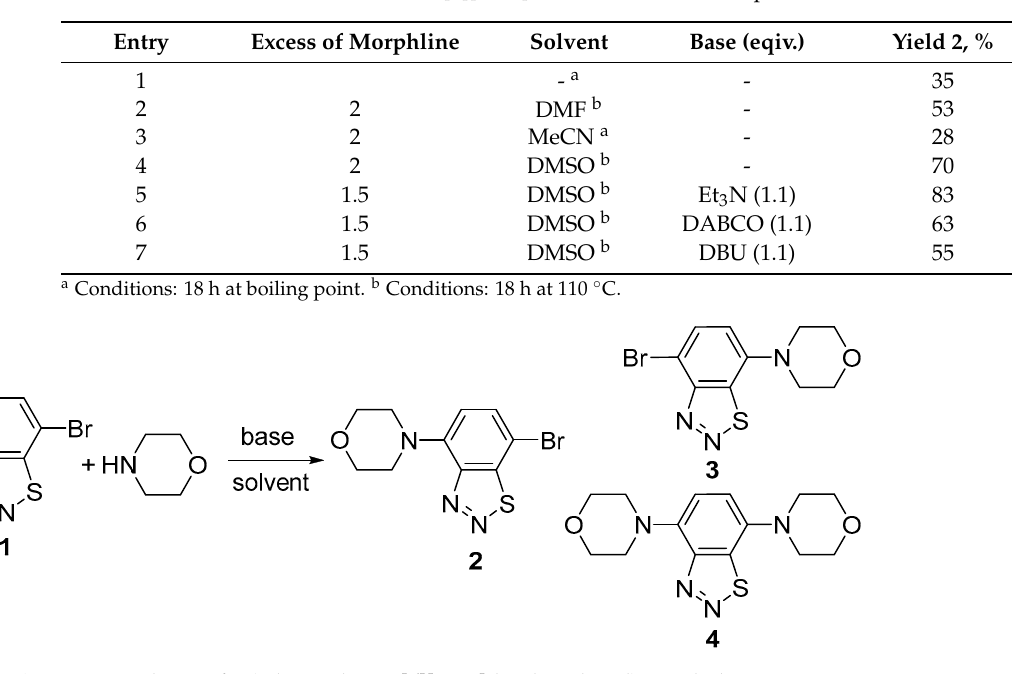
Table 1. Reaction of 4,7-dibromobenzo[ d ][1,2,3]thiadiazole 1 with morpholine.